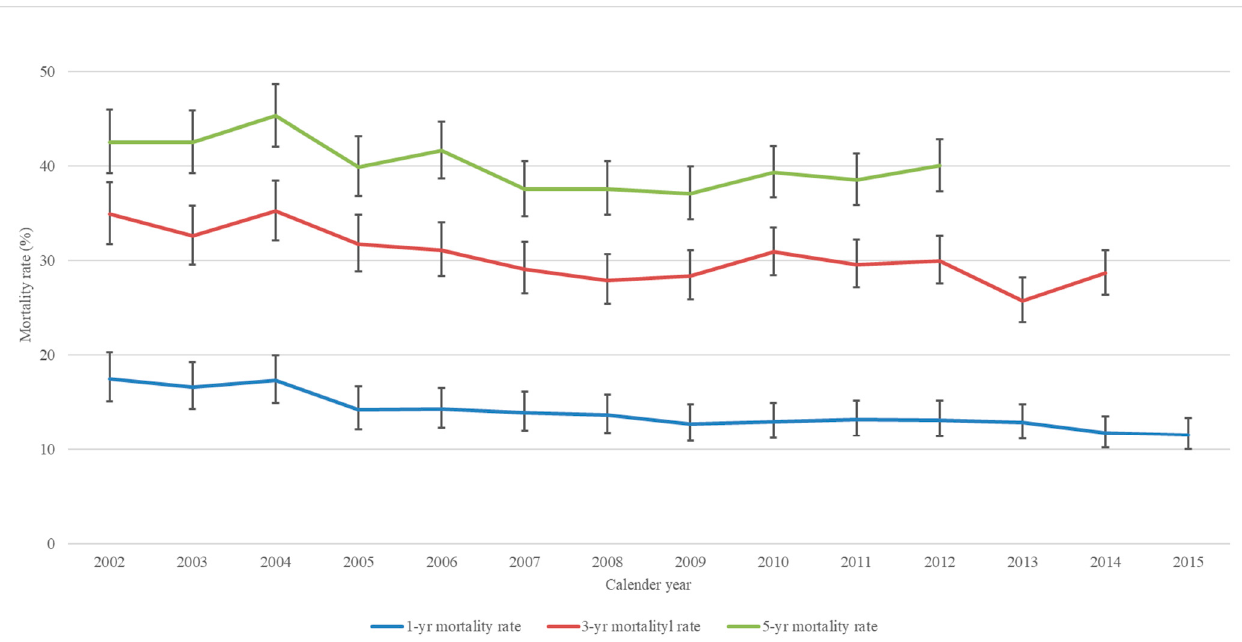
Figure 3. Trends of the one-, two-, and five-year mortality rate of ovarian cancer in Taiwan from 2002 to 2015 (blue: 1-year mortality rate; red: 3-year mortality rate; green: 5-year mortality rate).